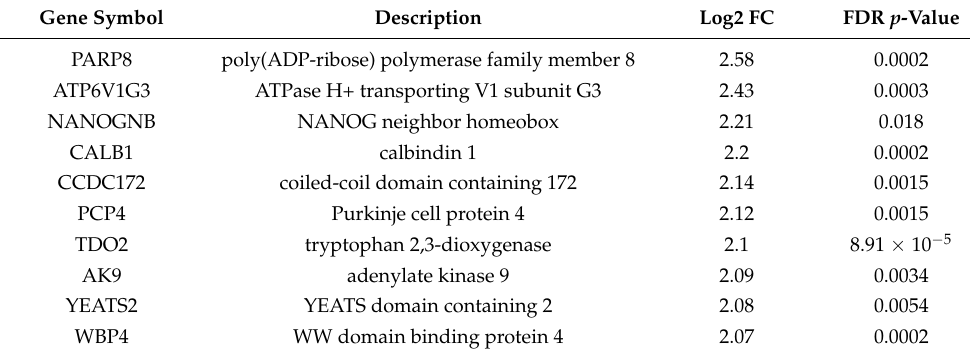
Table 1. Top ten up-regulated genes in VECs cultured in CM